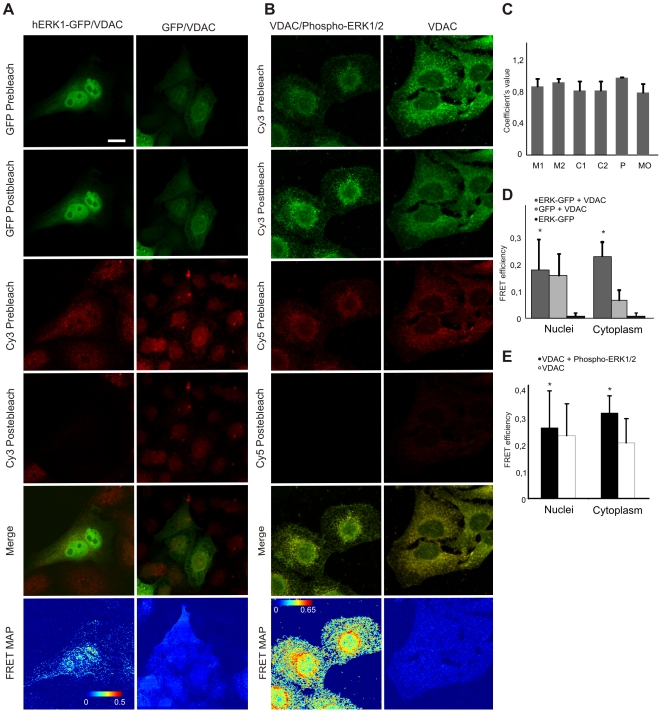
ERK interaction with VDAC.(A) HeLa cells transfected with hERK1-GFP, fixed and labelled against VDAC. Secondary antibody was conjugated with Cy3. The GFP and Cy3 images prior and after Cy3 photobleaching, the merged image of GFP and Cy3 prior to photobleaching and a FRET map according to Eq. 1 are shown. Bar = 10 µm. Color bar = FRET efficiency. Negative control: the same FRET experiment in HeLa cells transfected with GFP and further stained against VDAC as above. Representative images shown on the right. (B) HeLa cells fixed and stained with antibodies to phospho-ERK and VDAC. Secondary antibodies conjugated to Cy5 and Cy3, respectively. Cy3 and Cy5 images prior and after Cy5 photobleaching, a merged image of Cy3 and Cy5 prior to photobleaching and a FRET map in accord to Eq. 1 are shown. Bar = 10 µm. Color bar = FRET efficiency. Negative control: HeLa cells labelled against VDAC with both secondary antibodies; image series shown on the right. (C) Colocalization indexes estimated for HeLa cells transfected with hERK1-GFP and labelled for VDAC as in (A). M and C coefficients were estimated for both green and red channel images (Mgreen, Mred, Cgreen, Cred). P = Pearson's correlation coefficient, MO = Manders Overlap Coefficient. (D) Mean FRET efficiency in HeLa cells transfected with hERK1-GFP and labelled for VDAC as in (A) in accord to Eq. 1. Negative controls: HeLa cells transfected with GFP and labelled against VDAC plus Cy3 for specificity (light grey bars) and HeLa cells transfected with hERK1-GFP and no further staining for a FRET negative value (black bars); *p<0.5 with respect to GFP transfected cells. (E) Mean FRET efficiency in HeLa cells labelled for phospho-ERK and VDAC plus Cy5 and Cy3, respectively, in accordance with Eq. 1. Negative controls: HeLa cells labelled with antibody to VDAC plus both secondary antibodies for specificity (white bars); *p<0.5 with respect to negative control (Student's t test).